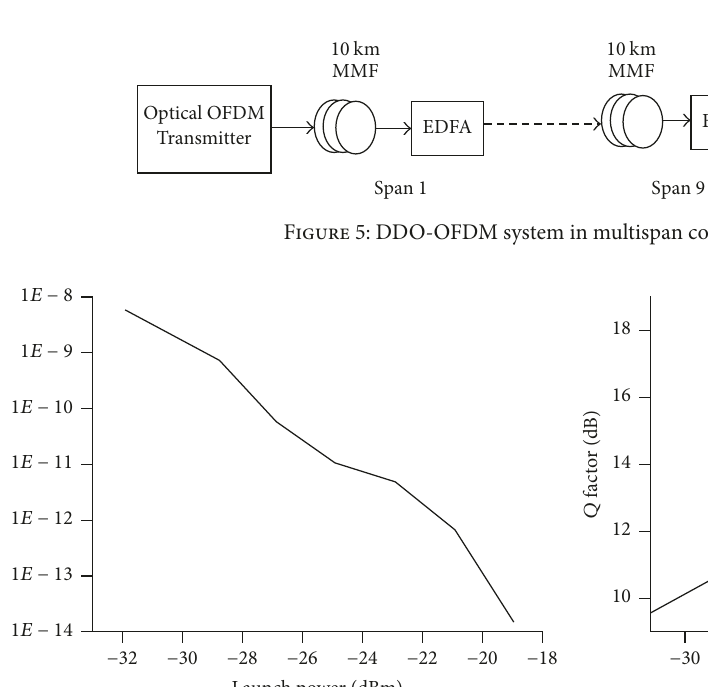
Figure 4: Performance analysis of the proposed DDO-OFDM system using an MMF link in terms of (a) BER and (b) 𝑄 factor.